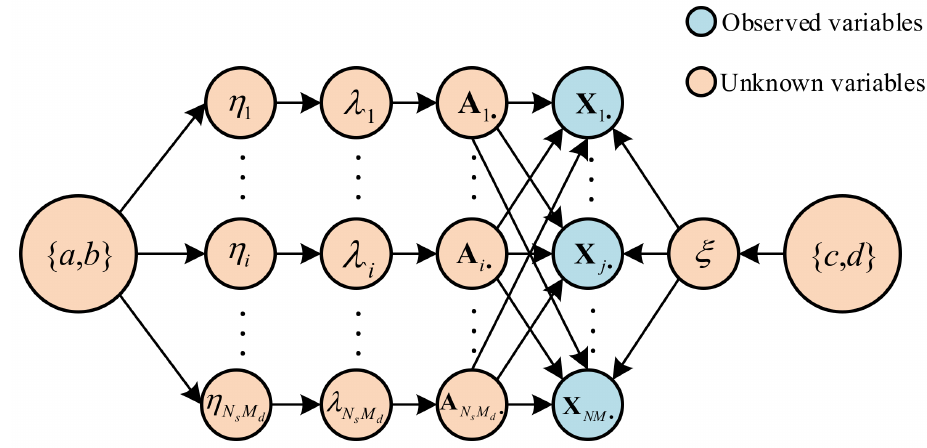
Figure 2. Graphical model of the proposed hierarchical Bayesian model with complex adaptive Laplace prior.